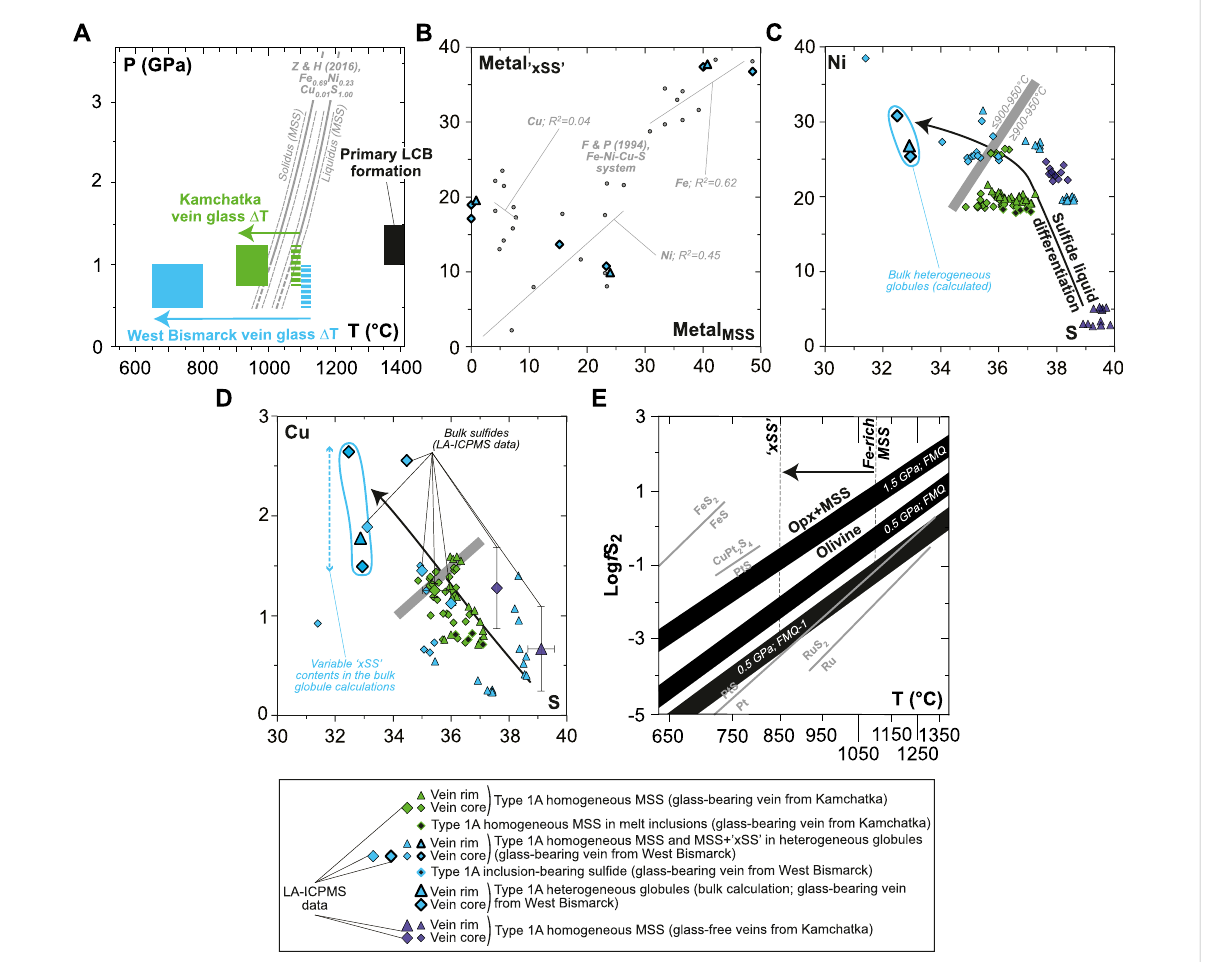
FIGURE 10 Constraints on sul fi de formation and sul fi de liquid fractionation for Kamchatka and West Bismarck Type 1A veins (SEM). (A) Plot of pressure against temperature showing the variable undercooling degrees ( Δ T) experienced by the glass-forming melt in veins from Kamchatka (green fi elds) and West Bismarck (blue fi elds). These are compared with the experimental liquidus and solidus of MSS in the Fe-Ni-Cu-S system (gray lines; Zhang and Hirschmann, 2016). The inferred P-T conditions of primary melts formed from spinel harzburgite sources, as modeled by Bénard et al. (2018c) (black fi eld) are also shown. (B) Relationships between metal abundances (Fe, Ni, and Cu) in “ xSS ” and MSS from heterogeneous globules in the West Bismarck vein (all in wt%). These data are compared with the experimental results of Fleet and Pan (1994) in the Fe-Ni-Cu-S system (gray dots). (C) Niand (D) CuplottedagainstSforKamchatkaandWestBismarckveinsul fi des(allinwt%).TheheterogeneousglobulesfromWestBismarck are indicated using symbols with a bold black contour. (E) Plot of f S 2 (in log units) against temperature showing a range of vein sul fi de formation conditions (black fi elds), calculated using the olivine-opx+MSS equilibrium for variable P-T- f O 2 values following Eggler and Lorand (1993) (see text for details). Also shown in gray are f S 2 -T relationships for the univariant Ru-RuS 2 and Pt-PtS curves (Barin, 1995), the stability fi eld of malanite (CuPt 2 S 4 ; Peregoedova and Ohnenstetter, 2002), and the univariant FeS-FeS 2 curve (Vaughan and Craig, 1978). Note that the lower-end, P- f O 2 conditions inferred from SCSS data in Figures 1A,B (0.5 GPa; FMQ-1), together with the temperature range for Fe-rich MSS to xSS crystallization (ca. 850 – 1,100 ° C; black arrow), place f S 2 -T conditions for the formation of vein sul fi des close to the Pt-PtS univariant